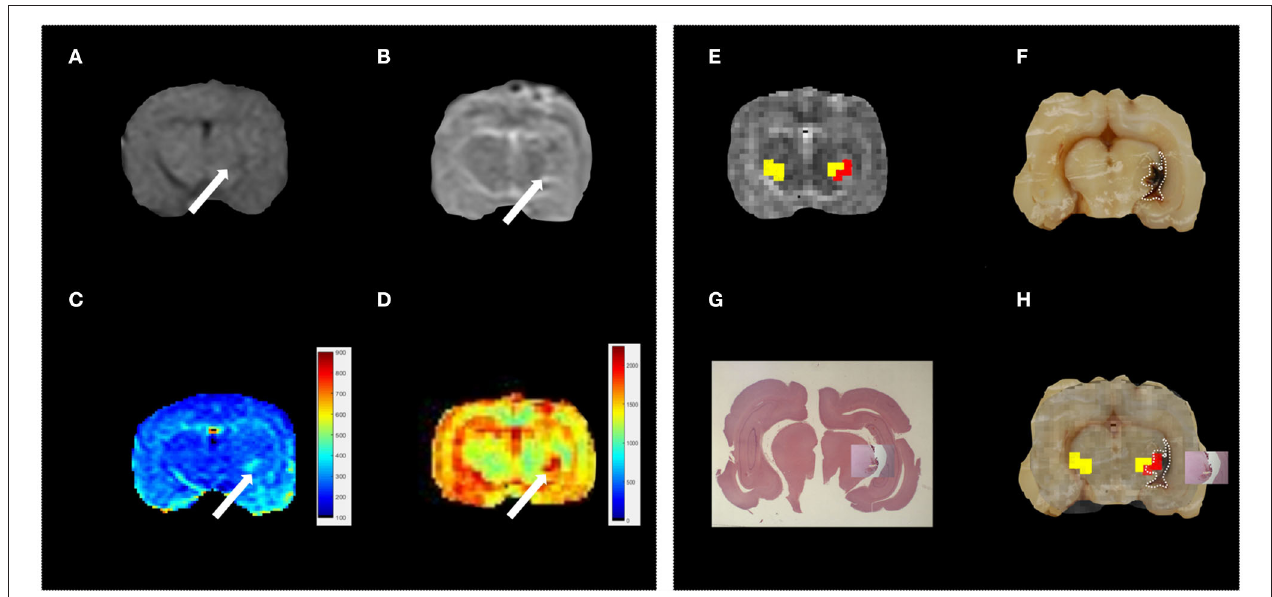
FIGURE 4 | Standard vs. MRR analyses and histopathological validation. Example 3. In all panels, the left brain hemisphere is on the right part of the image. (A) T1w transverse image of the brain; the lesion appears ill-defined, hypointense, and irregular in the left thalamus (white arrow), (B) T2w transverse image of the brain. As in T1w, the lesion in the left thalamus appears ill-defined, irregular but hyperintense (white arrow), (C,D) T1 and T2 maps, respectively. A hyperintense and irregularly shaped area is visible in both maps (white arrow), (E) the output of the hierarchical cluster overlaid on the T2 map. Voxels classified as “pathological” and “healthy” parenchyma are reported in red and yellow, respectively, (F) the results of gross anatomy. From the photograph of the brain section, the contour of the hemorrhagic lesion that appears irregular in shape and involves the left thalamus (white arrow) has been delineated (white dotted line), (G) histopathology results. The overall brain section obtained from the microscope with the hemorrhagic lesion shown in greater detail superimposed on the overall section, and (H) the hemorrhagic lesion found by the MRR approach (red voxels) is in agreement with the gross anatomy. Voxels classified as pathological fall inside the true lesion contour. It can be noted that in (F) the hemorrhagic area appears more extended than the lesion histologically evident (G) . However, this can be due to postmortem blood spread in the space between the left hemisphere and the ipsilateral thalamus. The contour of the hyperintense area in both T1 and T2 maps is in very good agreement with the hemorrhagic area evident from the histopathological results where the blood spread disappeared after the formalin fixation.